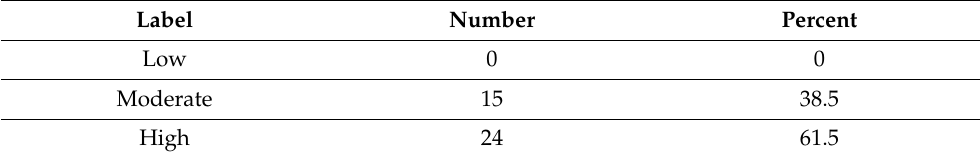
Table 5. Class label distribution. Label